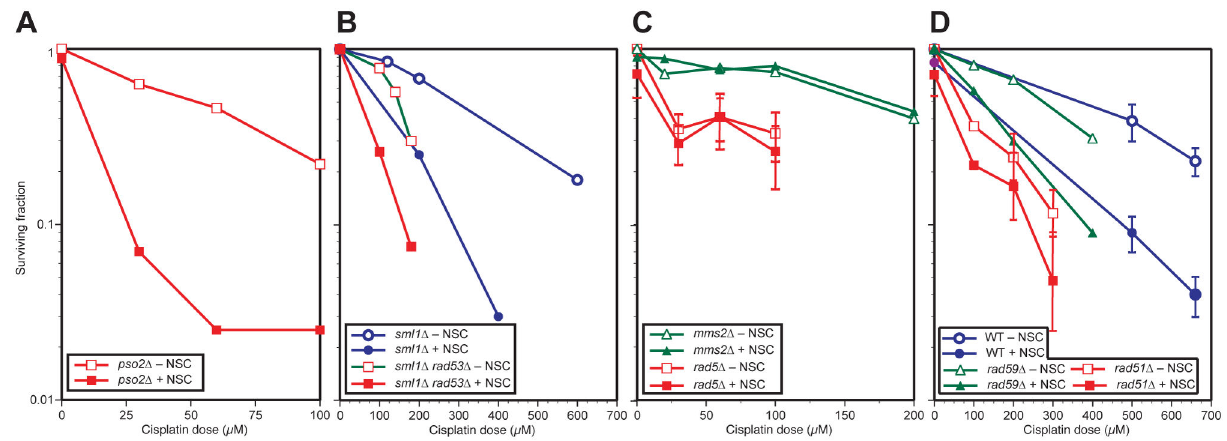
Figure 3. Dose response curves of wild type and various isogenic haploid mutant strains, treated with cisplatin alone or with cisplatin and NSC109268 combined. (A) Survival analysis of pso∆ , (B) sml1 ∆ and sml1 ∆ rad53 ∆, (C) mms2∆ and rad5∆ , (D) rad51 ∆ and rad59 ∆ as compared to wild type (BY4741). Surviving fractions of colony forming cells were plotted as a function of CP dose. Logarithmic-phase cells were treated, with or without NSC109268 (3 μM), for 2 h at 30°C. Use of symbols is indicated in the figure. Symbols without error-bars indicate single representative experiments. doi: